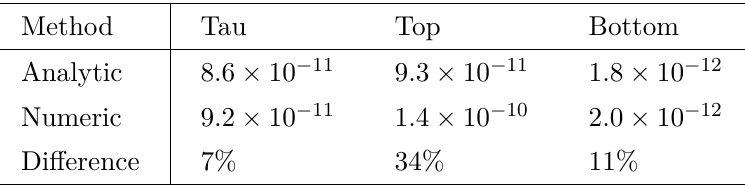
Table 5. Differences between the analytic and numeric results of Y B . In all cases, the differences are O (1) , which is within the overall uncertainties in our